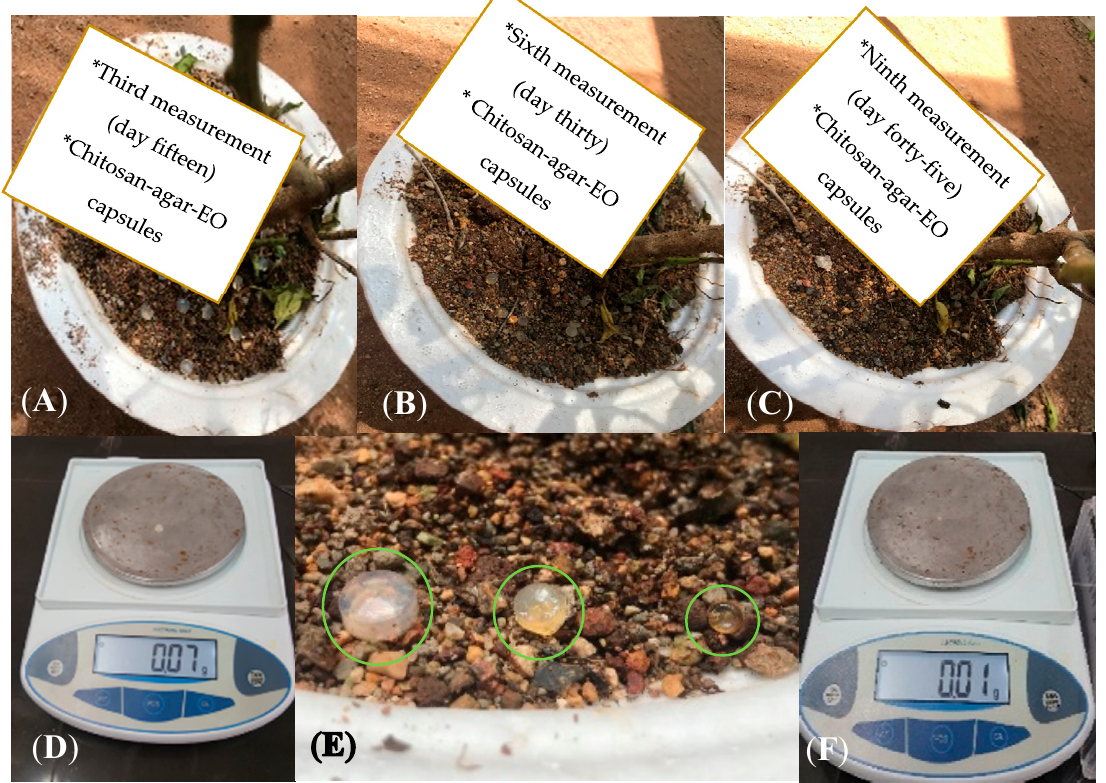
Figure 5. Consistency and weight measurement process during days 15, 30, and 45 of the test with a 100%, 50%, and 10% reduction in weight, respectively ( A – C ). Weight loss ratio of Chitosan-Agar-EO capsules from day 1 to day 45 ( D – F ).